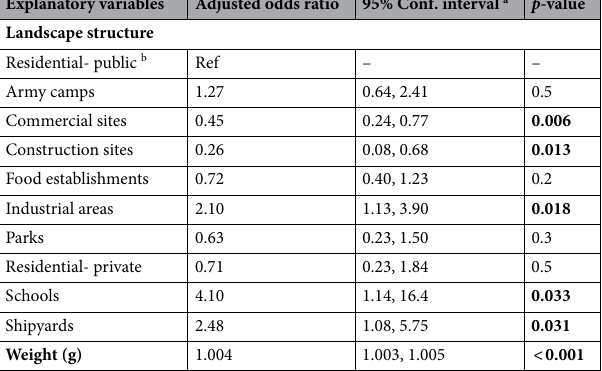
Table 7. Multivariable logistic regression model for Rickettsia typhi antibody detection in Rattus rattus and Rattus norvegicus . Significant values ( P < 0.05) are shown in bold. a 95% Confidence Interval. b Reference